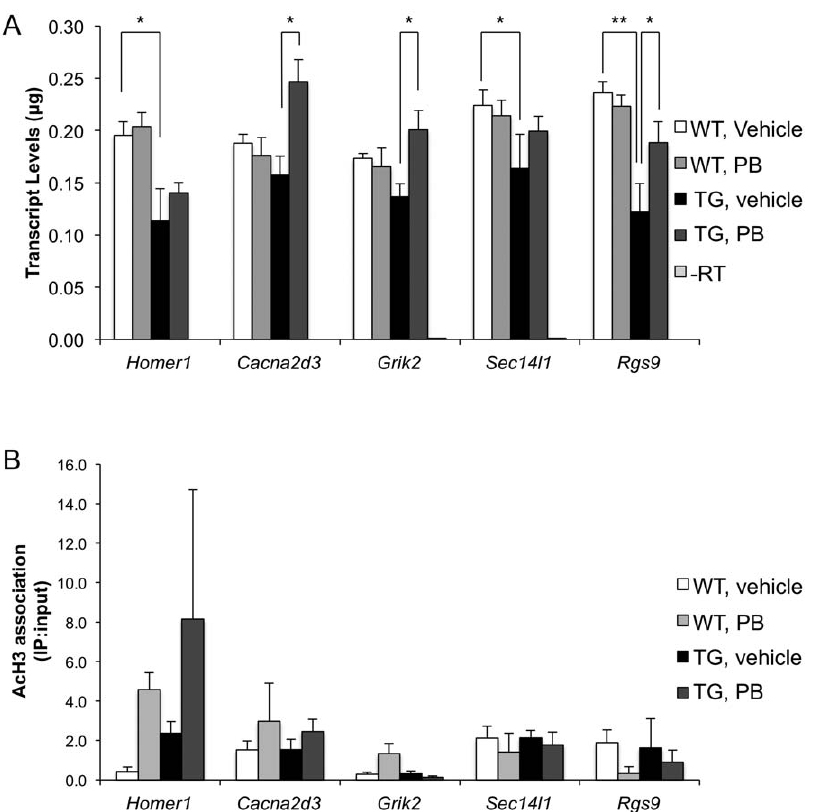
Figure 10. Phenylbutyrate treatment increases transcript levels of downregulated gene in TG striata but does not increase acetylation levels at gene loci. (A) Transcript levels of downregulated genes in the Tg striata. (B) Single-gene ChIP for the enrichment of AcH3 at gene regions. White bars, WT, vehicle treated; Light grey bars, WT, phenylbutyrate treated; Black bars, Tg, vehicle treated; Dark grey bars, Tg, phenylbutyrate treated. *, p , 0.05; **, p , 0.01. Error bars are standard deviation.